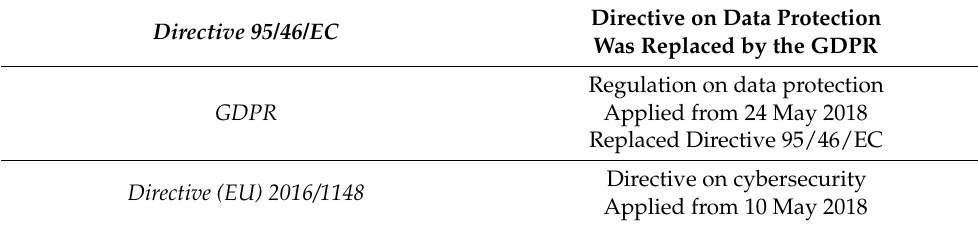
Table 1. Regulatory framework in the EU on data